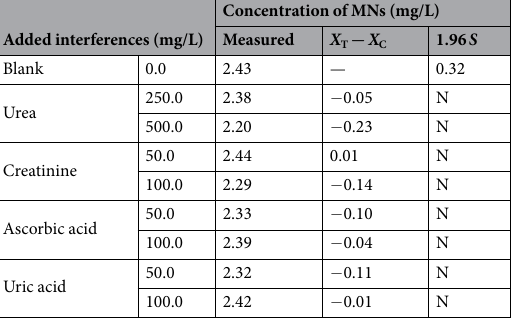
Added interferences (mg/L)